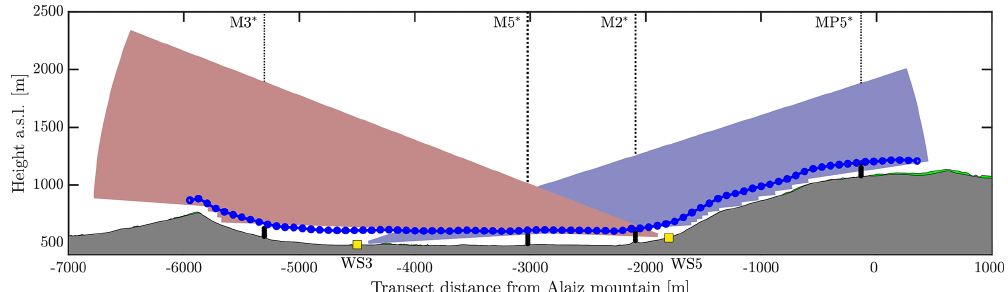
Figure 4. Transect scan on the vertical plane spanned by WS3 and WS5 (yellow squares). Shaded areas represent the superimposed RHI scans after a hard target filtering. The blue dots show the transect scan measured by WS2 and WS4 (out of the plane). The black dots indicate the positions of the masts M3, M5, M2 and MP5 when projected onto the transect’s plane.